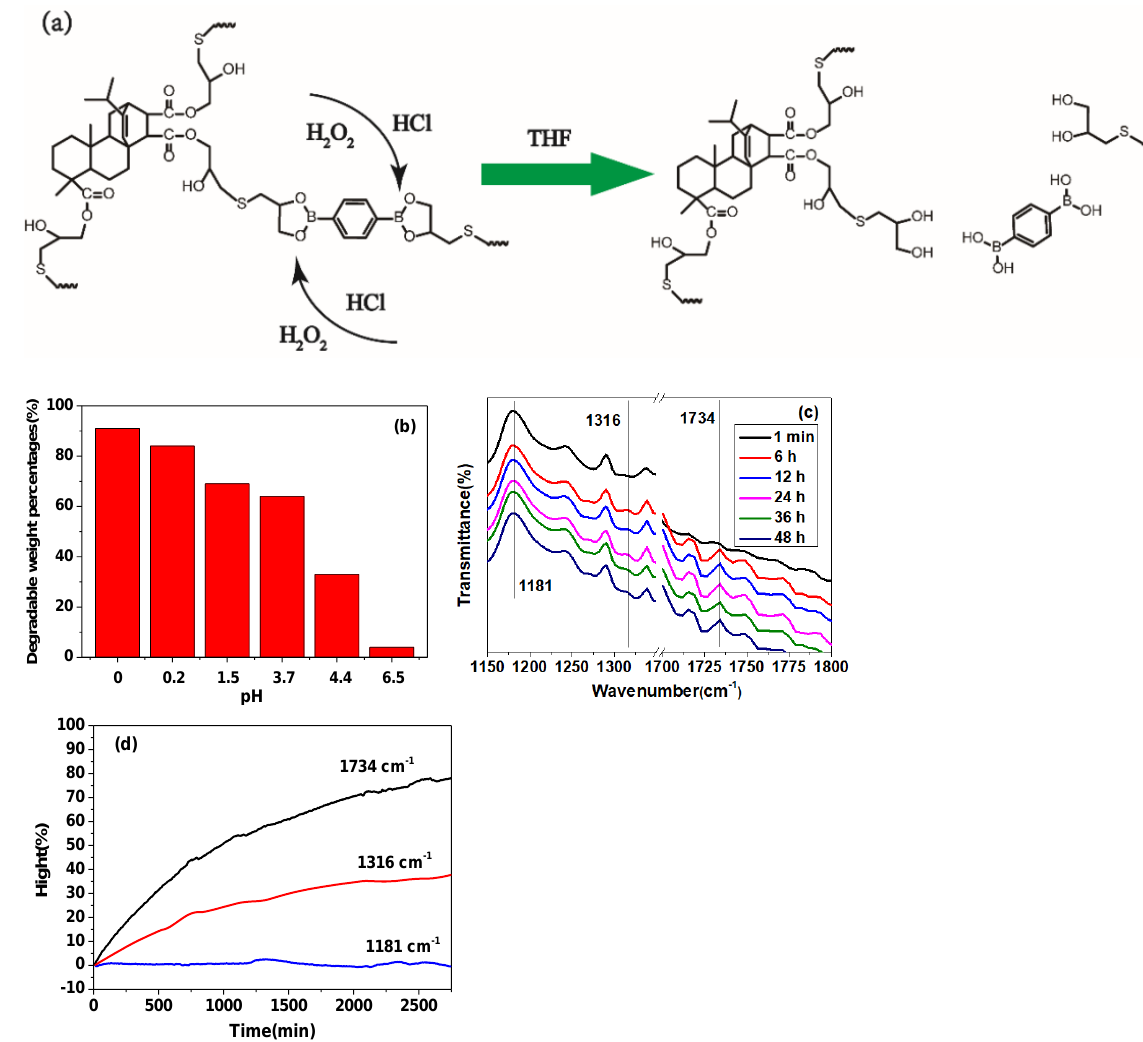
Figure 12. ( a ) Schematic representation of C-FPAE degradation. ( b ) The degradation weight percentage of 20% C-FPAE in mixed solutions with different pH. ( c ) Real-time FTIR spectra of 20% C-FPAE in mixed solution with pH = 0 for different times. ( d ) The height of the three characteristic peaks of FTIR (at 1734, 1316 and 1181 cm − 1 ) during the degradation